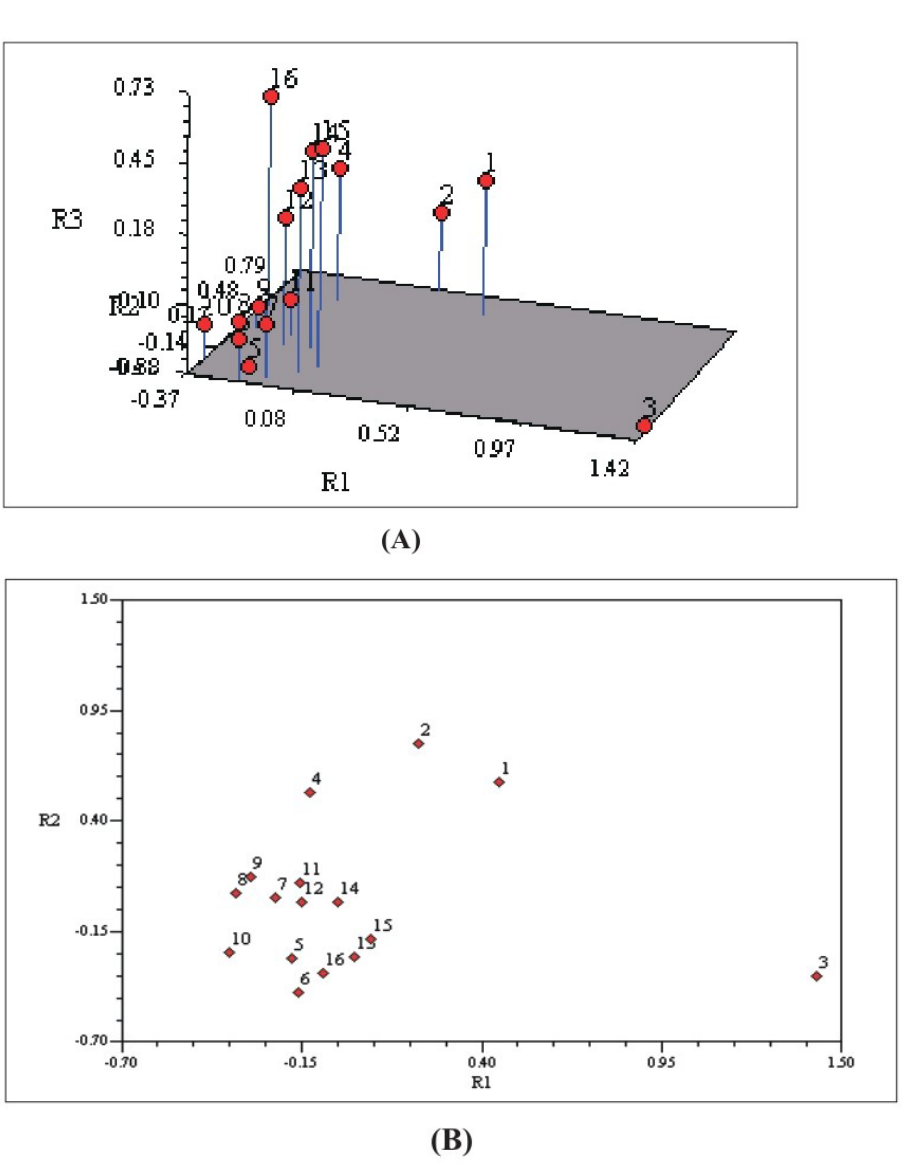
Figure 3. Three–dimensional ( A ) and two-dimensional ( B ) plots of principal component analysis based on ISSR in 16 S. cumini populations. The numbers are plotted to represent individual geno- types.